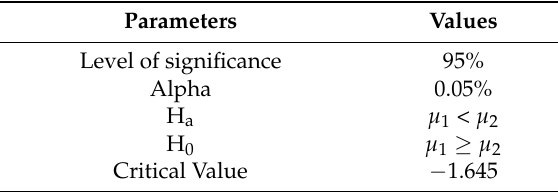
Table 2. Statistical z-test parameters.